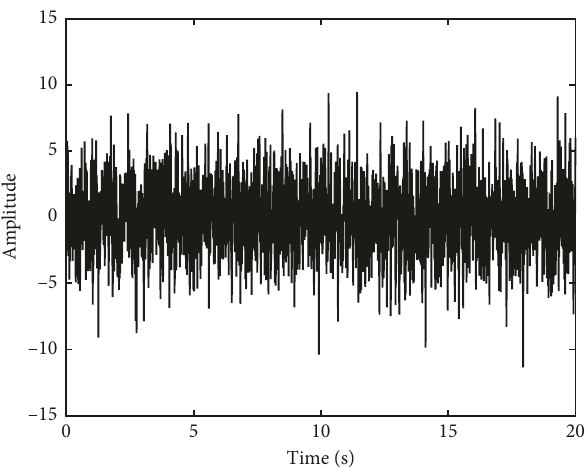
Figure 8: Waveform of SFM signal.